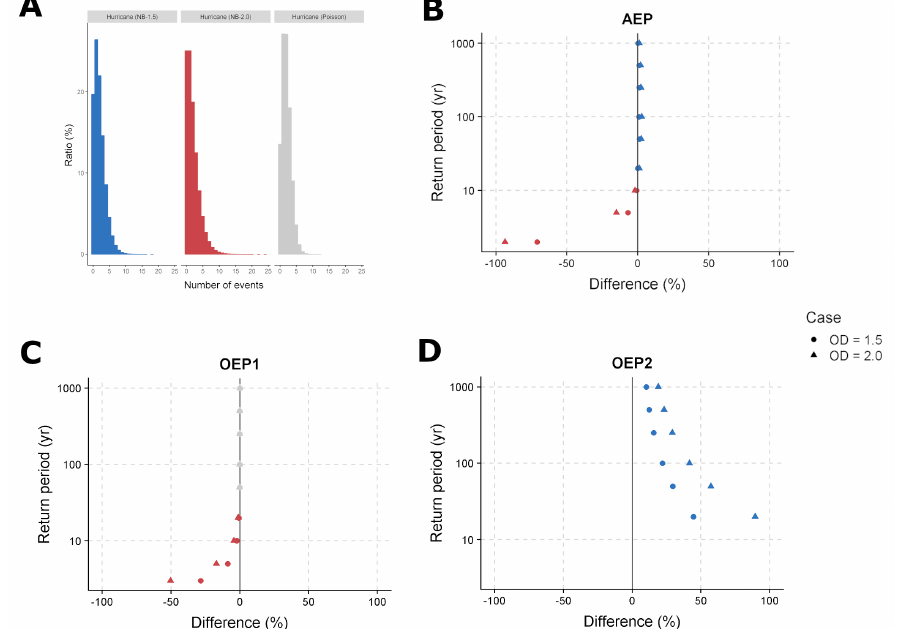
Figure 11. ( Panel A ) depicts discrete frequency distributions for the Poisson and two over-dispersive sensitivity models. ( Panel B ) depicts percent differences in the AEP relative to the Poisson baseline, and ( Panels C , D ) have the analogous results for the order M = 1 and M = 2